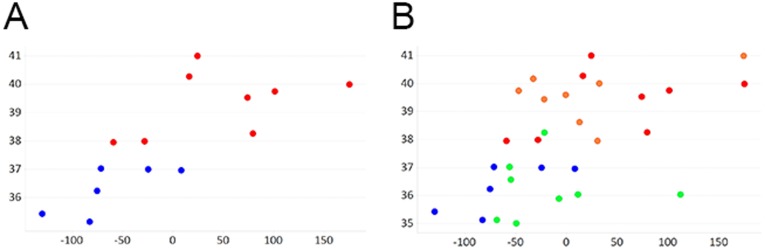
The largest source of variation in the transcriptomics data is associated with gestational age across samples.Prinicipal component analysis using the RNA expression microarray data across just the normal birthweight samples (A) or across all samples (B), returned principal component 1 (x-axis) which has a significant correlation with gestational age of the samples. Samples are classified into high birth weight group (>3700 g) in orange; low birthweight group (<2500 g) in green; normal birthweight and gestational age less than or equal to 37 weeks in blue; or normal birthweight and gestational age more than 37 weeks in red.